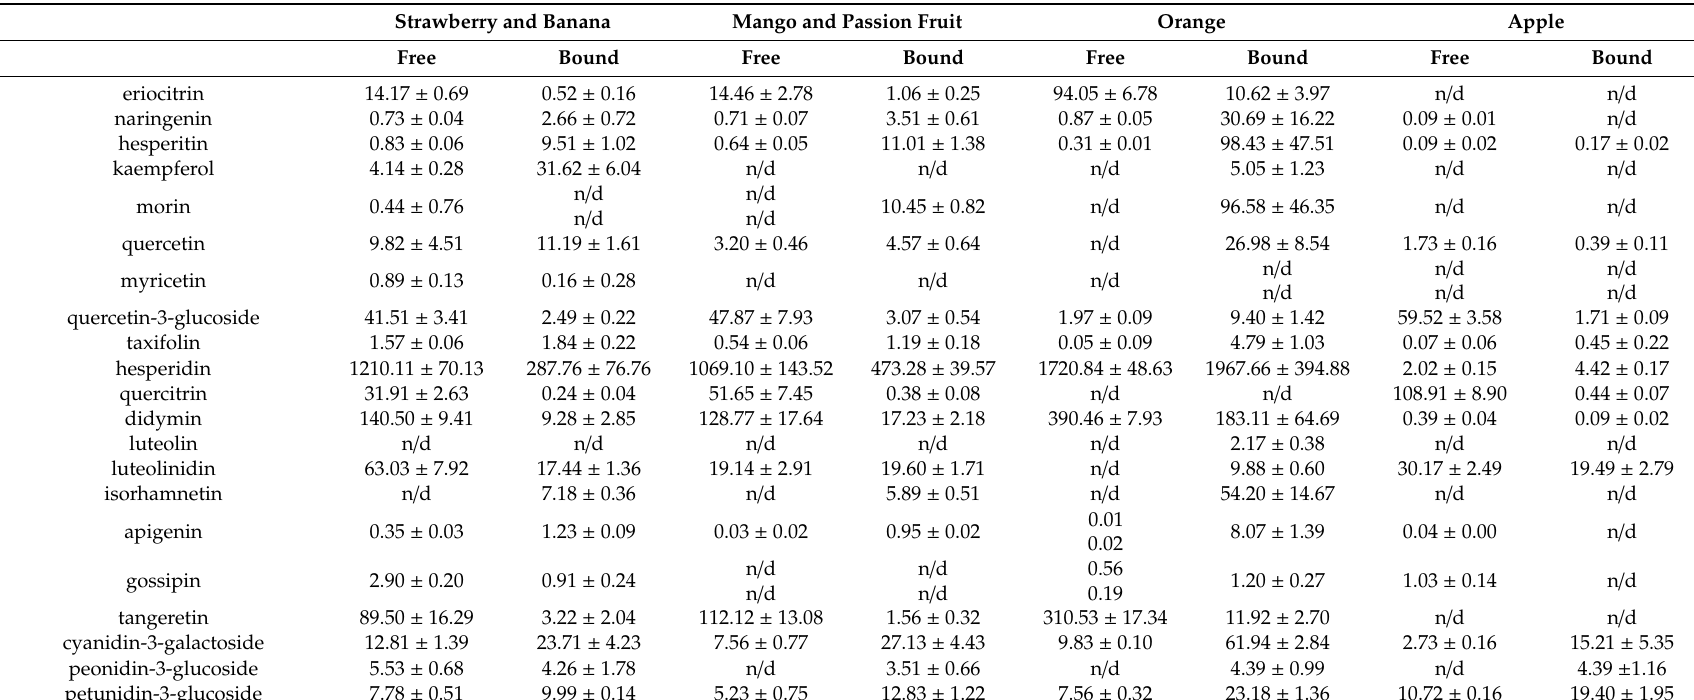
Table 7. Flavonoid content of juice / smoothie